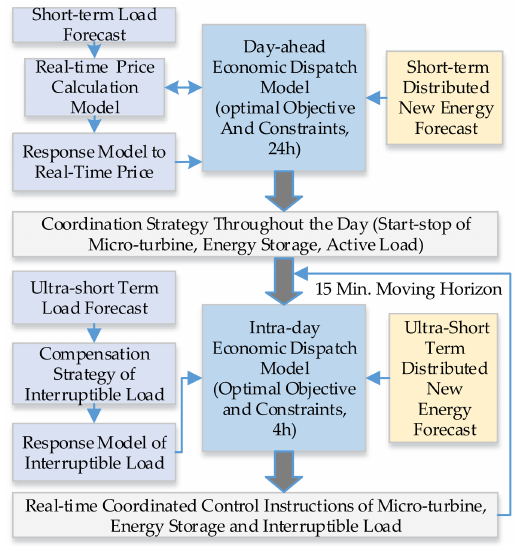
Figure 2. Day-ahead and intra-day integrative dispatch architecture of